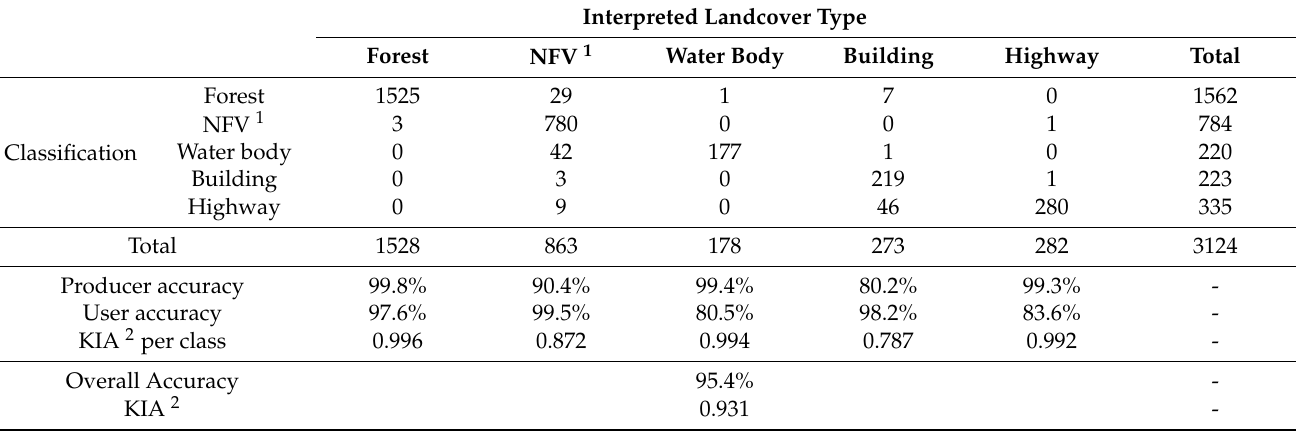
Table 3. Confusion matrix and the classification accuracy of the support vector machine (SVM) classifier trained for this research. The assessment is conducted on the image object